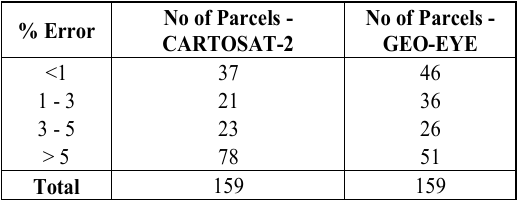
Table 6. Comparison of Perimeter deviation with respect to ETS-GPS in CARTOSAT-2 and